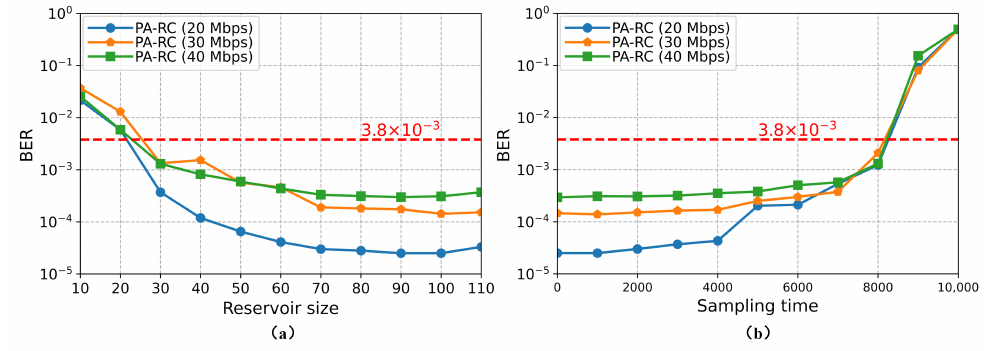
Figure 3. BER vs. RC parameters. ( a ) Neurons in the reservoir; ( b ) sampling